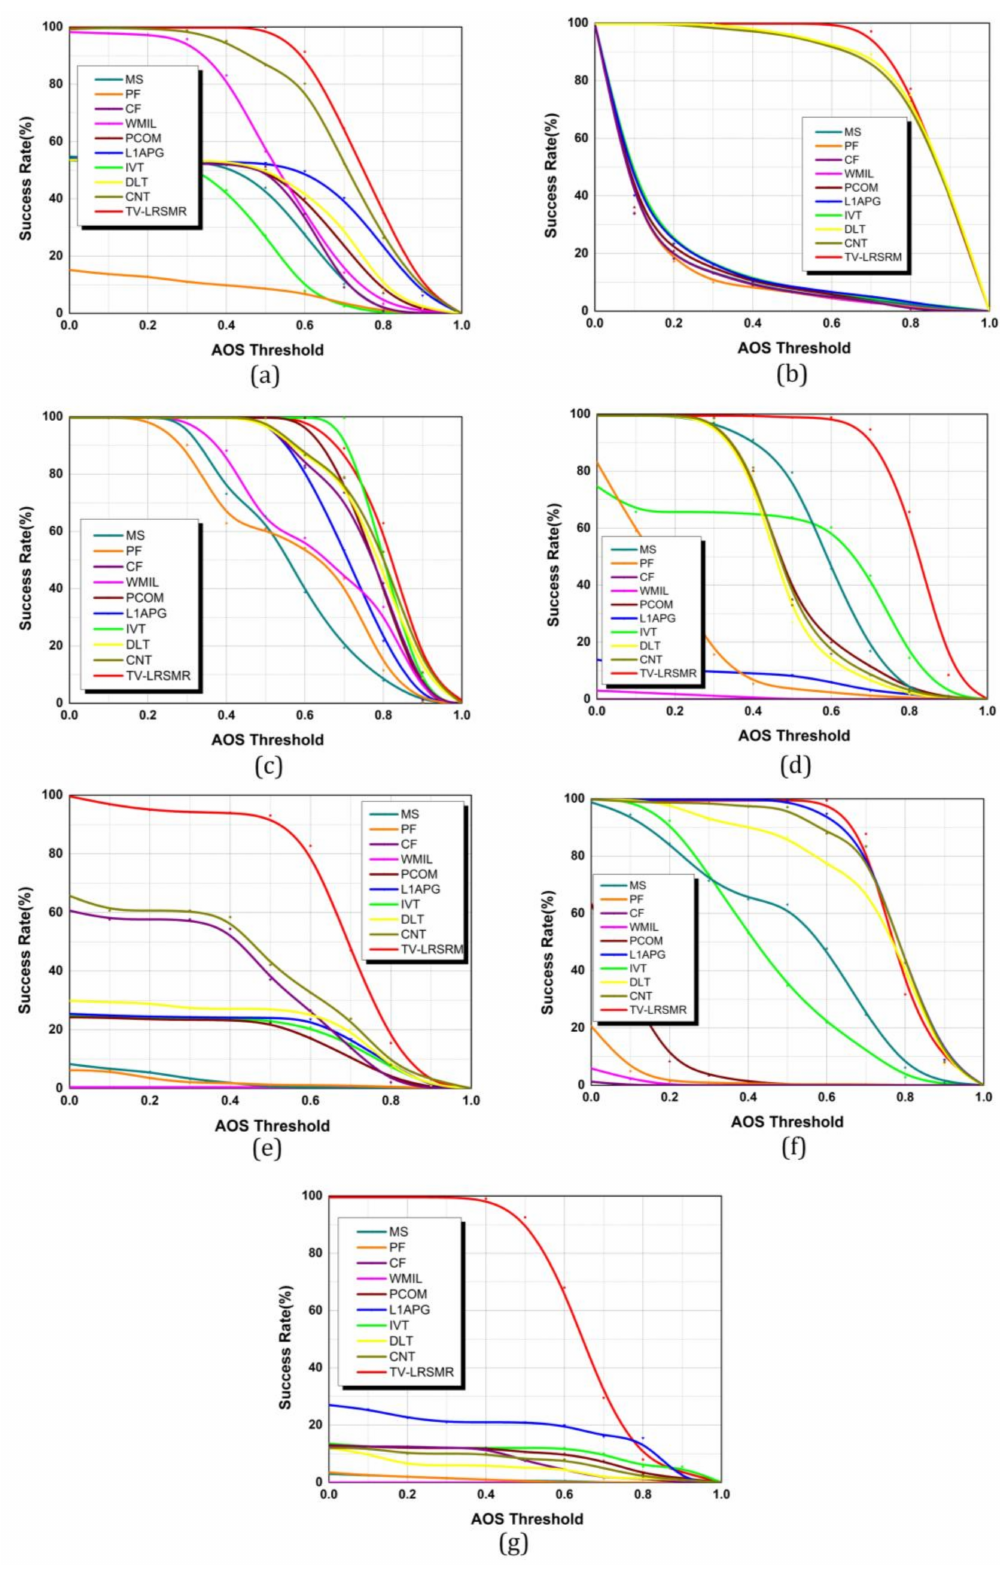
Figure 5. Success plots: ( a ) Seq.1; ( b ) Seq.2; ( c ) Seq.3; ( d ) Seq.4; ( e ) Seq.5; ( f ) Seq.6; and, ( g )